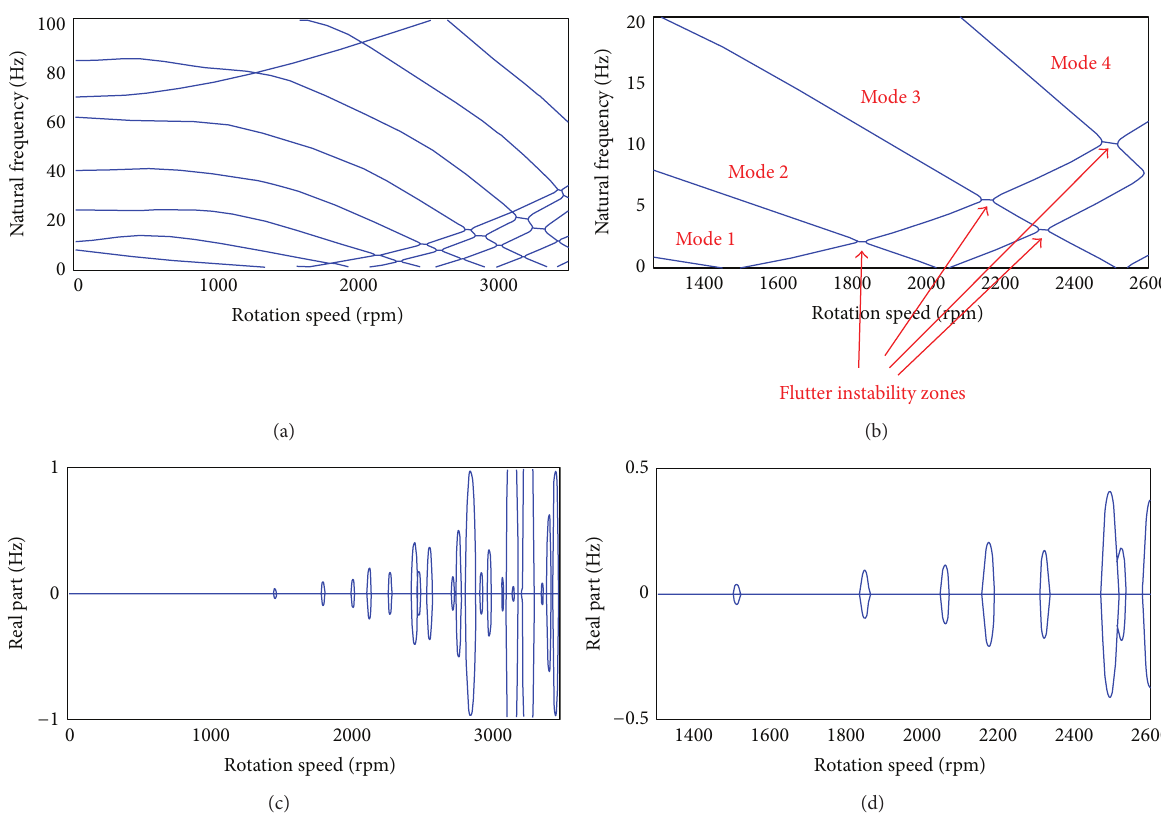
Figure 5: Imaginary and real parts of eigenvalues of the guided splined